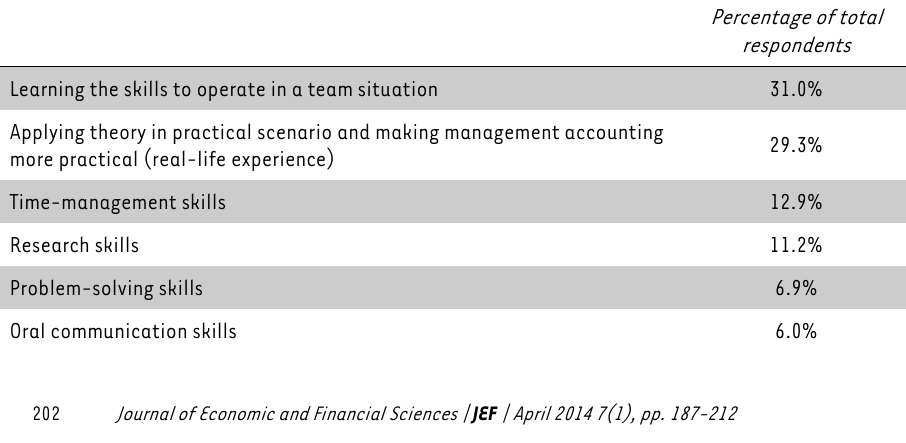
Most important benefits of management accounting